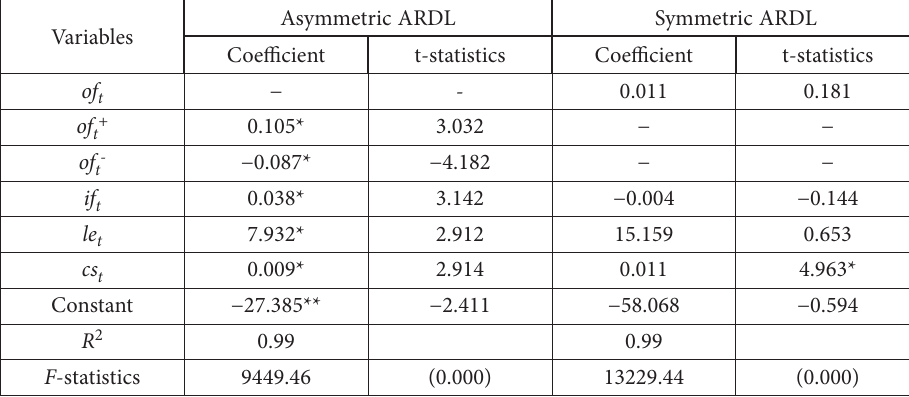
Table 4. Long run estimation results of symmetric and asymmetric ARDL